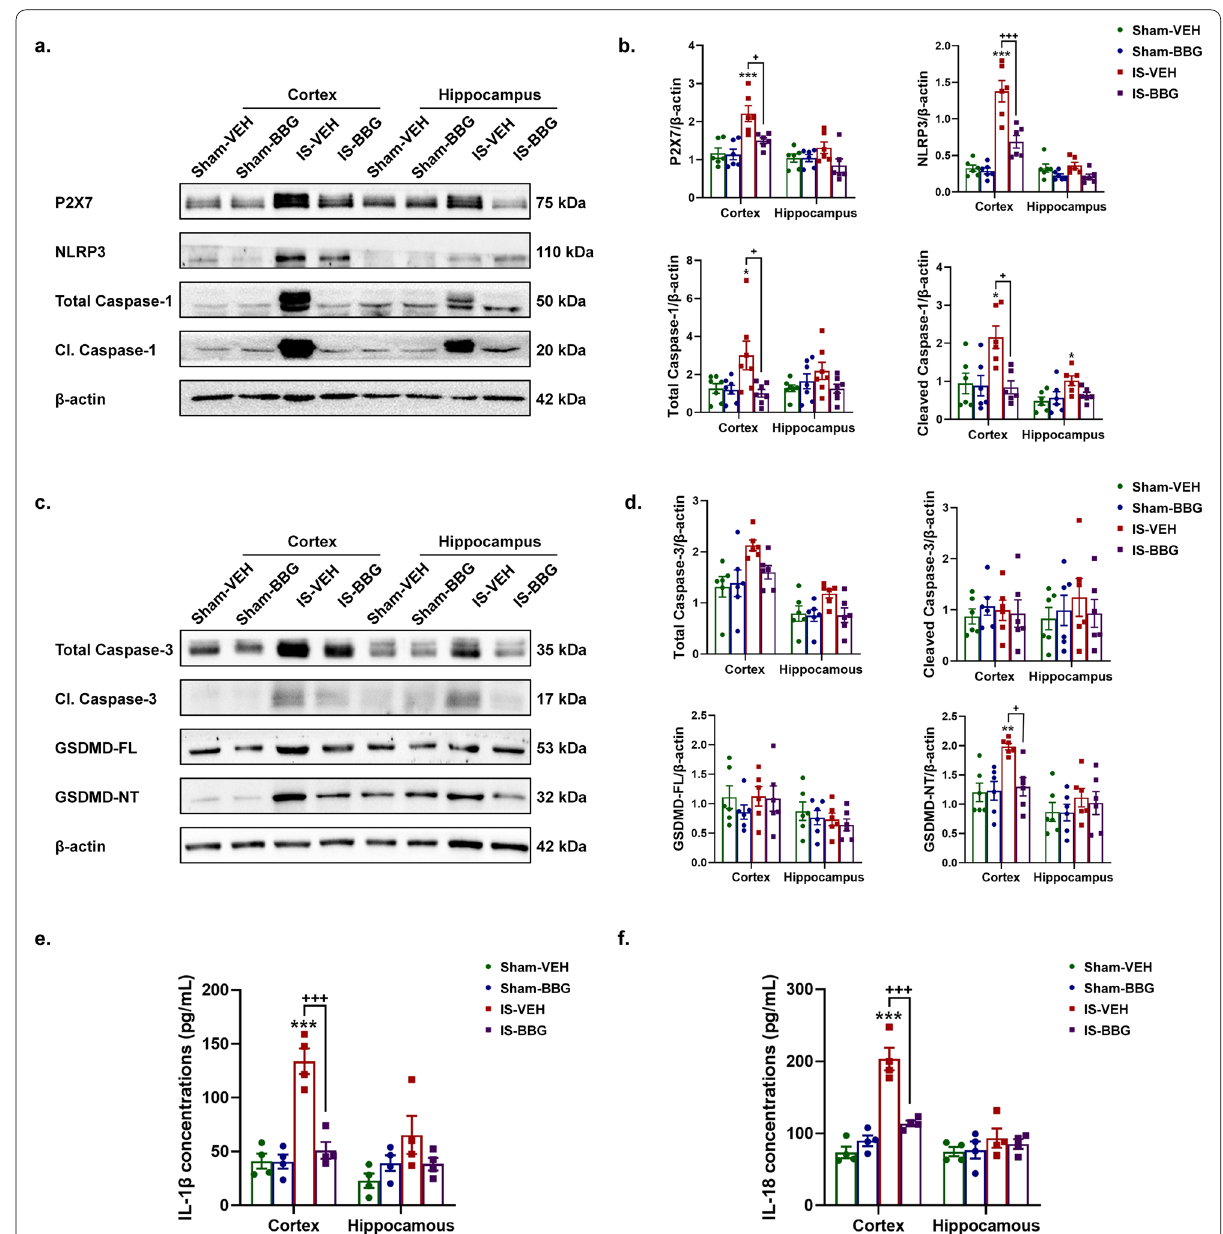
Fig. 5 Inhibition of P2X7R attenuated IS-induced NLRP3 inflammasome activation and pyroptosis. ( a - b ) Representative immunoblots and quantification showed decreased expression levels of P2X7R, NLRP3 (inflammasome receptor) and cleaved caspase-1 (marker of inflammasome activation) in the cerebral cortex of IS-BBG mice compared to IS-VEH mice ( n 6 mice per group). ( c - d ) Representative immunoblots and = quantification showed decreased expression levels of GSDMD-NT (pyroptotic marker) in the cerebral cortex of IS-BBG mice compared to IS-VEH mice ( n 6 mice per group). ( e – f ) ELISA results showed decreased release of IL-1β and IL-18 (direct downstream products of inflammasome = activation) in the cerebral cortex of IS-BBG mice compared to IS-VEH mice ( n 4 mice per group). * p < 0.05, ** p < 0.01 and *** p < 0.001 as compared = to sham-VEH mice; + p < 0.05, ++ p < 0.01 and +++ p < 0.001 as compared to IS-VEH mice. One-way ANOVA with Tukey’s multiple comparisons or Kruskal–Wallis with Dunn’s multiple comparisons test were performed for statistical analysis. Data are represented as mean SEM. Abbreviations: IS, ± inflammatory soup; BBG, brilliant blue G; VEH, vehicle; GSDMD-NT, N-terminal Gasdermin D; ELISA, enzyme-linked immunosorbent